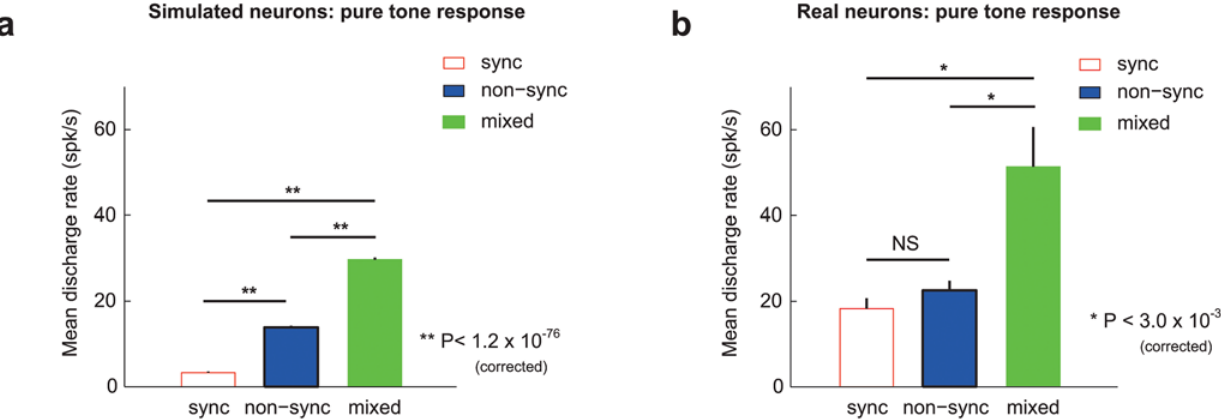
Fig 7. Discharge rates across mixed, synchronized, and non-synchronized neurons. Mean discharge rates for simulated (left) and real (right) neuronal populations, grouped according to their neural coding regime: synchronized (red), non-synchronized (blue), and mixed (green). Error bars indicate